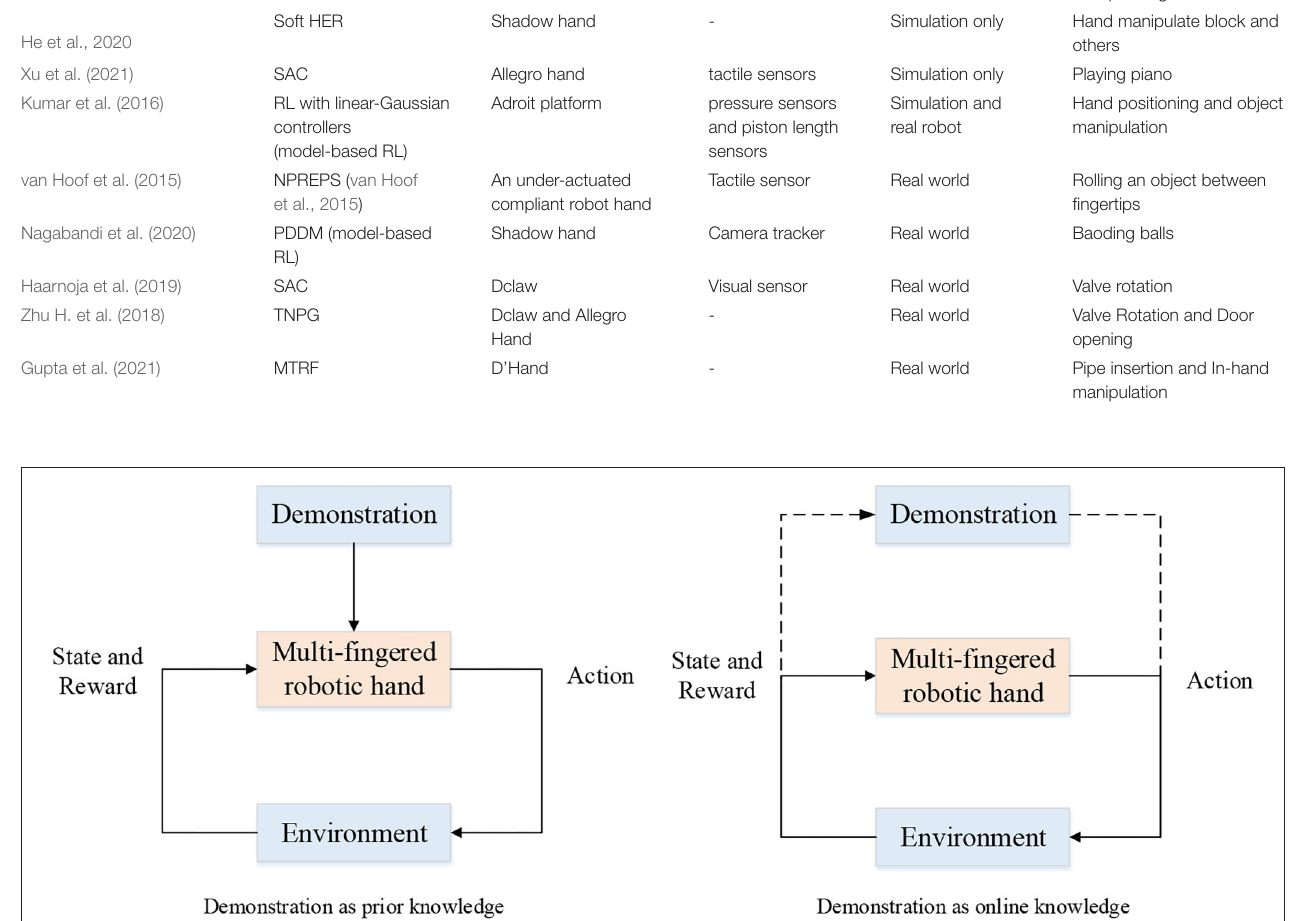
FIGURE 6 | Two types of combination of RL and